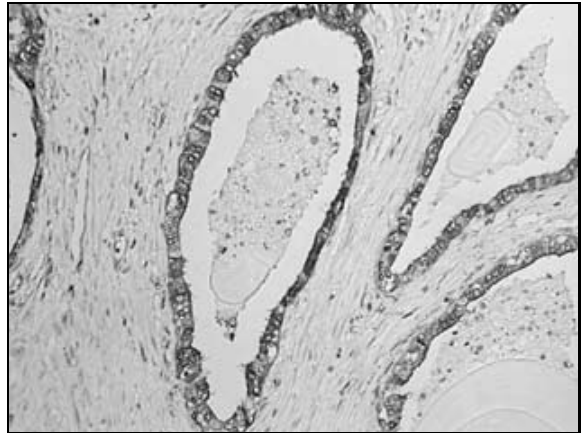
Figura 1 – Perfil da galectina-3 em tecido com hiperplasia prostática benigna (magnificação 200x)